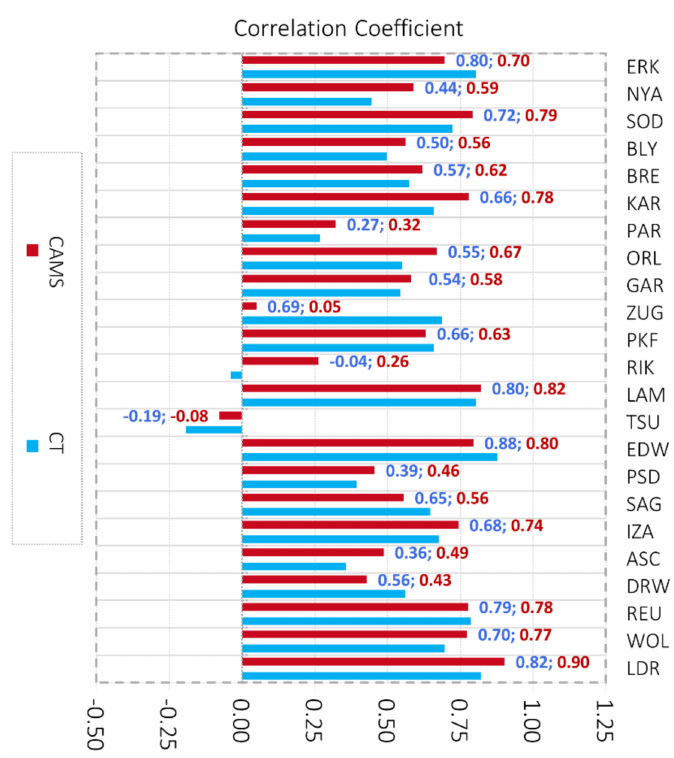
Figure 9. Correlation coefficients, between all available MGRs, for various TCCON stations and MGRs modeled by CAMS (red) and CT (blue). Simulations are provided for the same location and given at monthly temporal resolution. The stations are sorted from top to bottom of the plot using the station